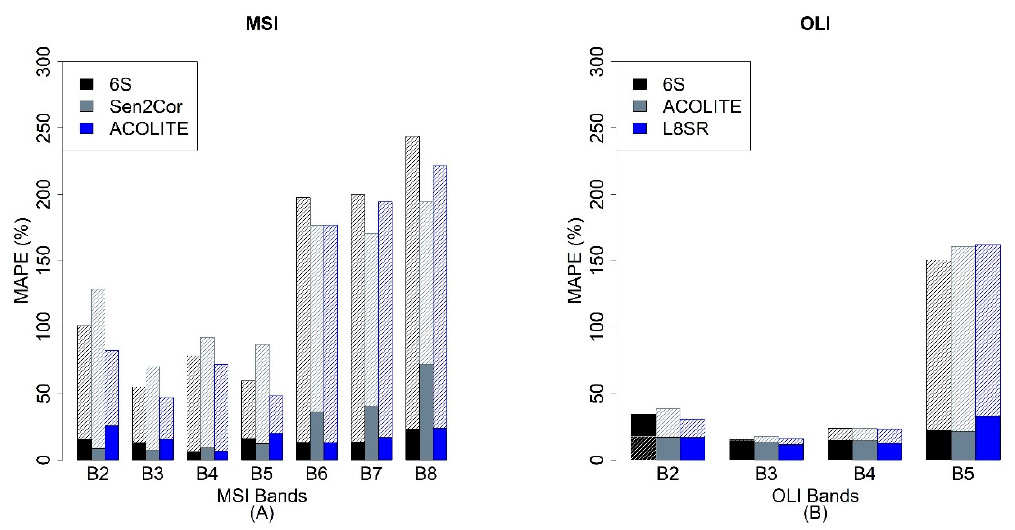
Figure 10. The MAPE values for the VNIR spectral bands of both MSI ( A ) and OLI ( B ) sensors: The hatched bars refer to the MAPE values before glint correction, and the solid bars refers to the MAPE values after glint correction for the three atmospheric correction methods for both sensors.